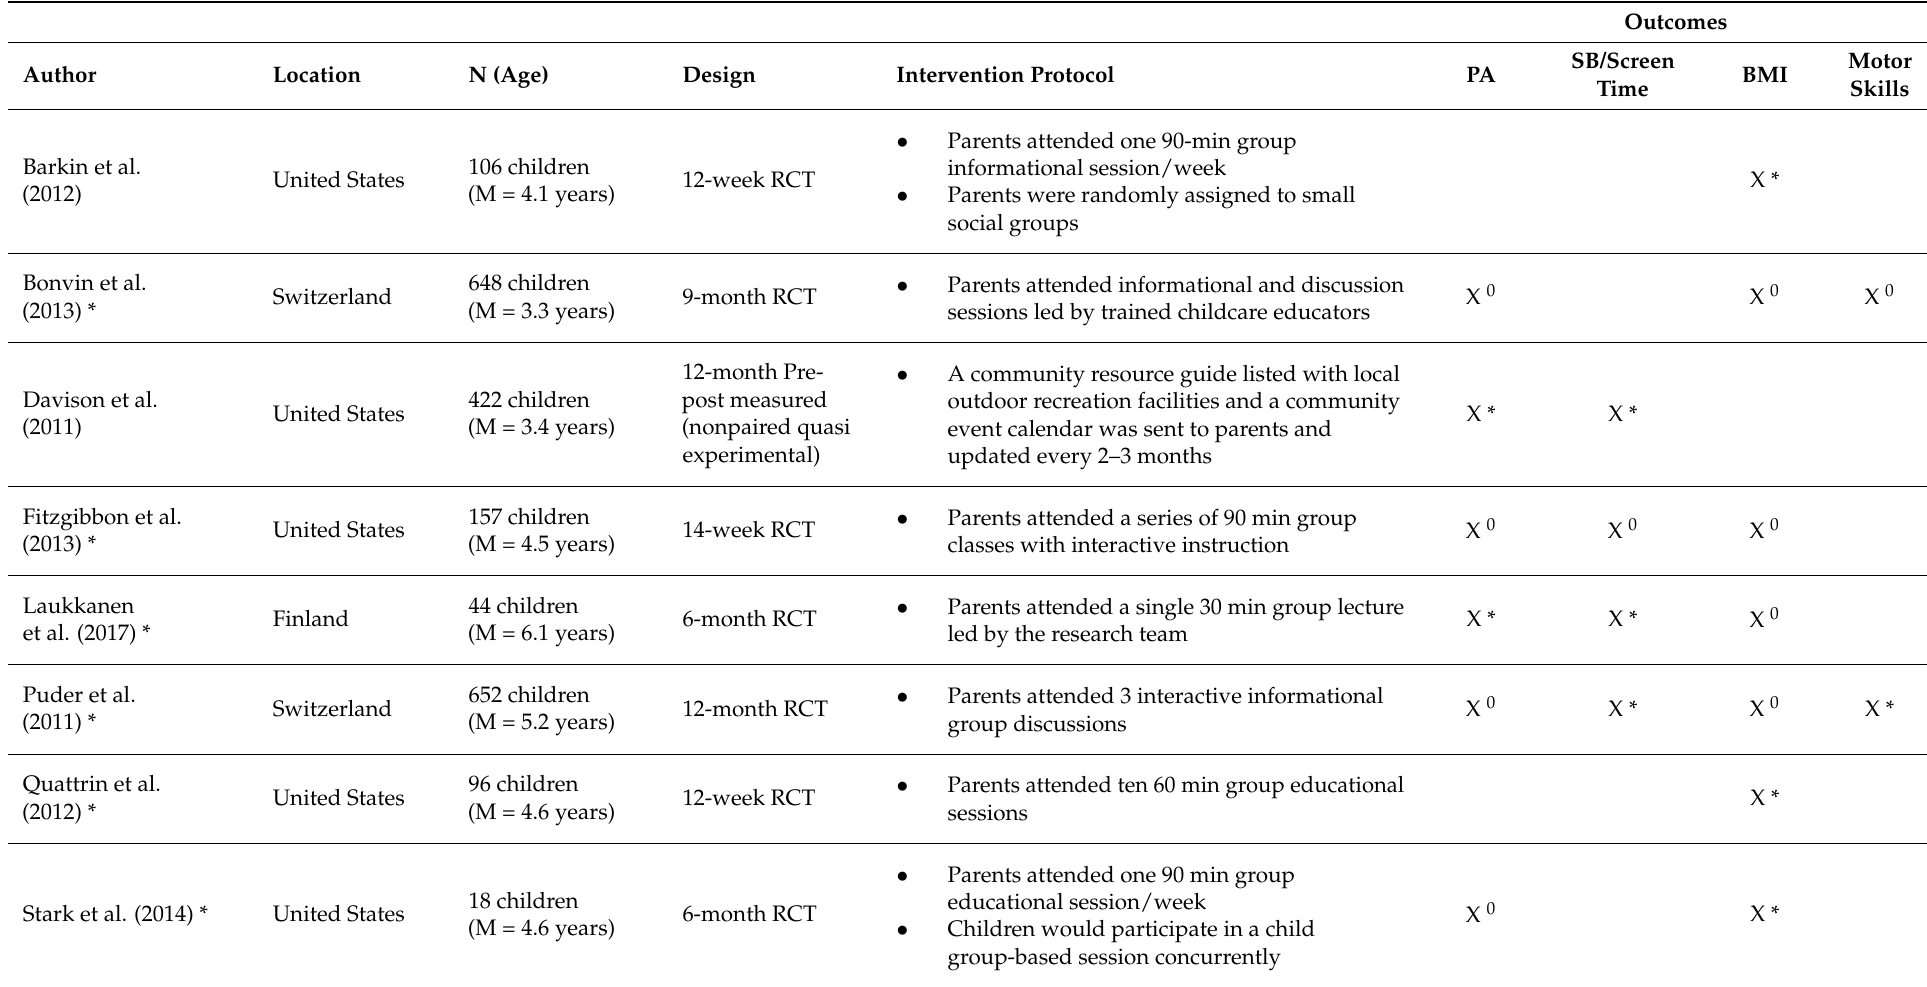
Table 4. Intervention effects of community-based interventions (n =